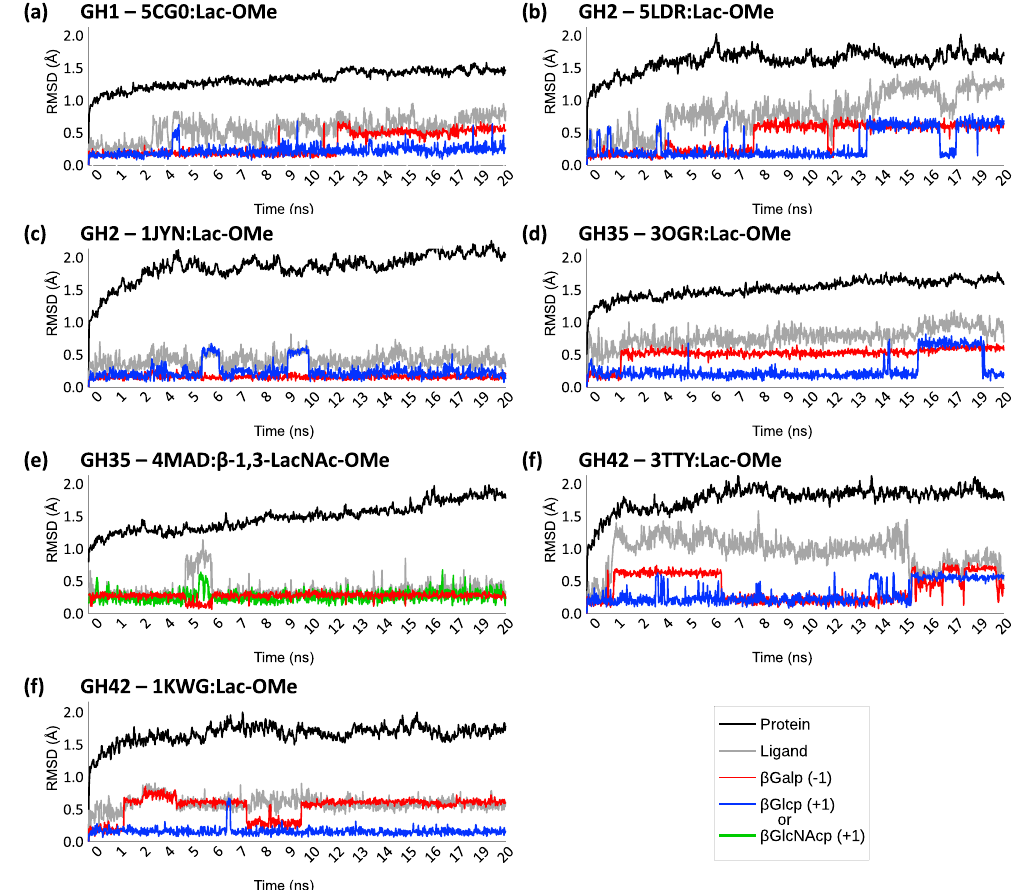
Figure 6. Relative flexibility of carbohydrate residues bound at subsites − 1 and + 1 during 20 ns MD simulations. The relative flexibility the residues found at subsites − 1 (red) and + 1 (dark blue) are contrasted with those of the full ligand (silver) and of the full protein (black) throughout 1,000 time steps of independent 20 ns MD simulations: ( a ) 1-methyl- β -lactoside = Lac-OMe (GH1, PDB ID: 5CGO); ( b ) 1-methyl- β - lactoside = Lac-OMe (GH2, PDB ID: 5LDR); ( c ) 1-methyl- β -lactoside = Lac-OMe (GH2, PDB ID: 1JYN); ( d ) 1-methyl- β -lactoside = Lac-OMe (GH35, PDB ID: 3OGR); ( e ) β -1,3-LacNAc-OMe (GH35, 4MAD); ( f ) 1-methyl- β -lactoside = Lac-OMe (GH42, PDB ID: 3TTY); ( g ) 1-methyl- β -lactoside = Lac-OMe (GH42, PDB ID: